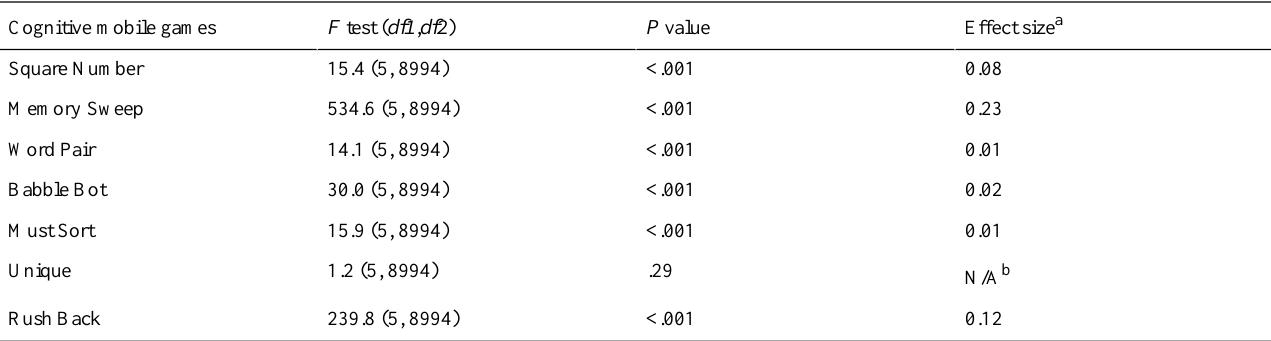
Table 1. One-way ANOVA and effect size results for each cognitive mobile